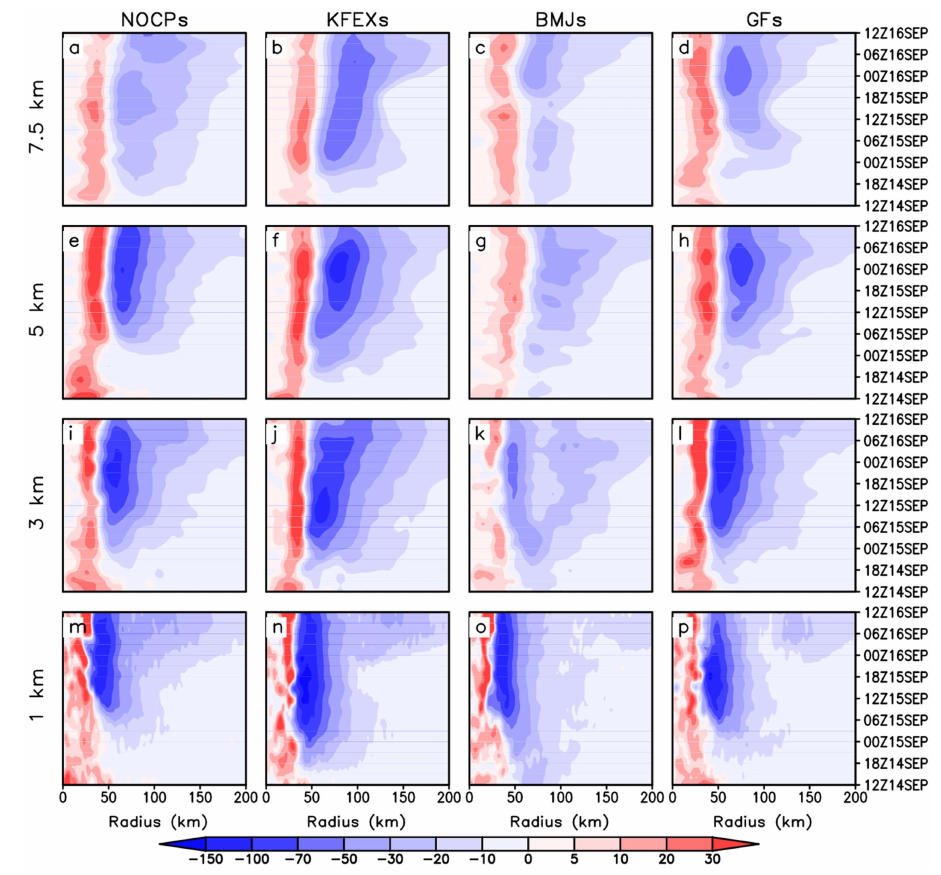
Figure 7. Hovmöller diagrams of the azimuthal-averaged net radial forcing term (m s − 1 h − 1 ) at 100 m height. The model resolution is 7.5 km ( a – d ), 5 km ( e – h ), 3 km ( i – l ) and 1 km ( m – p )